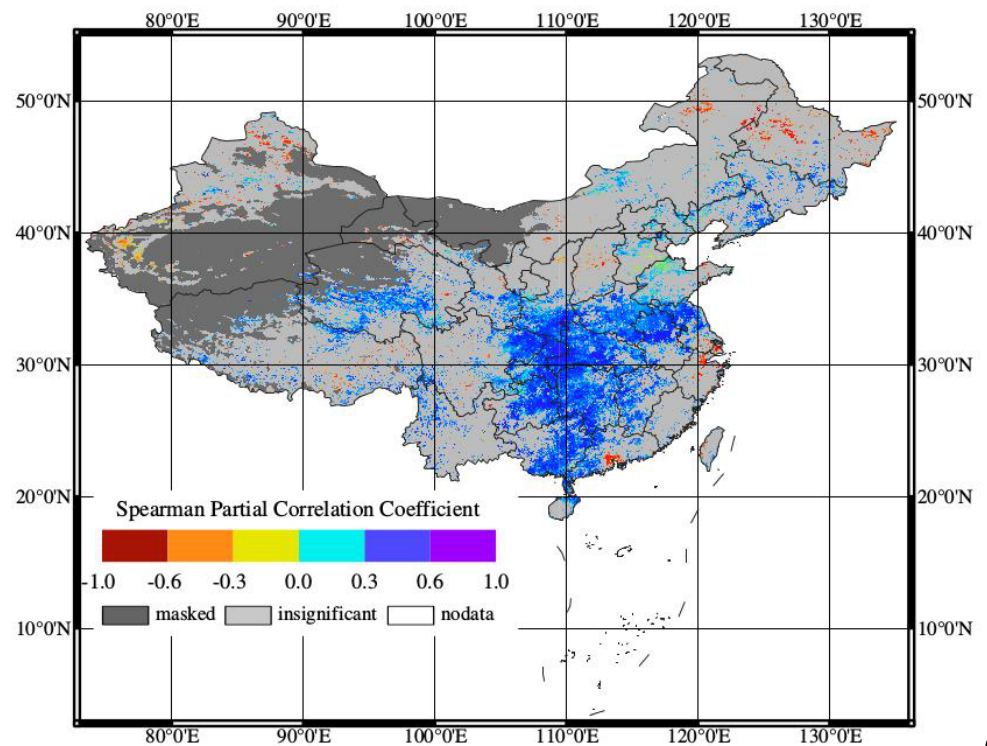
Figure 5. Map of correlation coefficients between annual mean NDVI with ( a ) annual mean air temperature and ( b ) annual total precipitation. White areas represent pixels with no data, light gray pixels represent insignificant trends, and dark gray pixels are masked with threshold of 30-year mean NDVI <